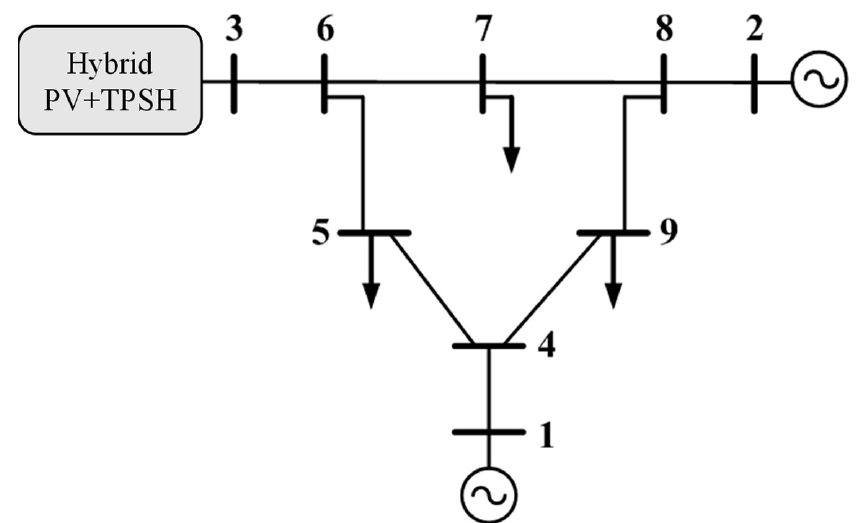
Figure 13. IEEE 9-bus system with proposed PV plant and controls at bus 3.